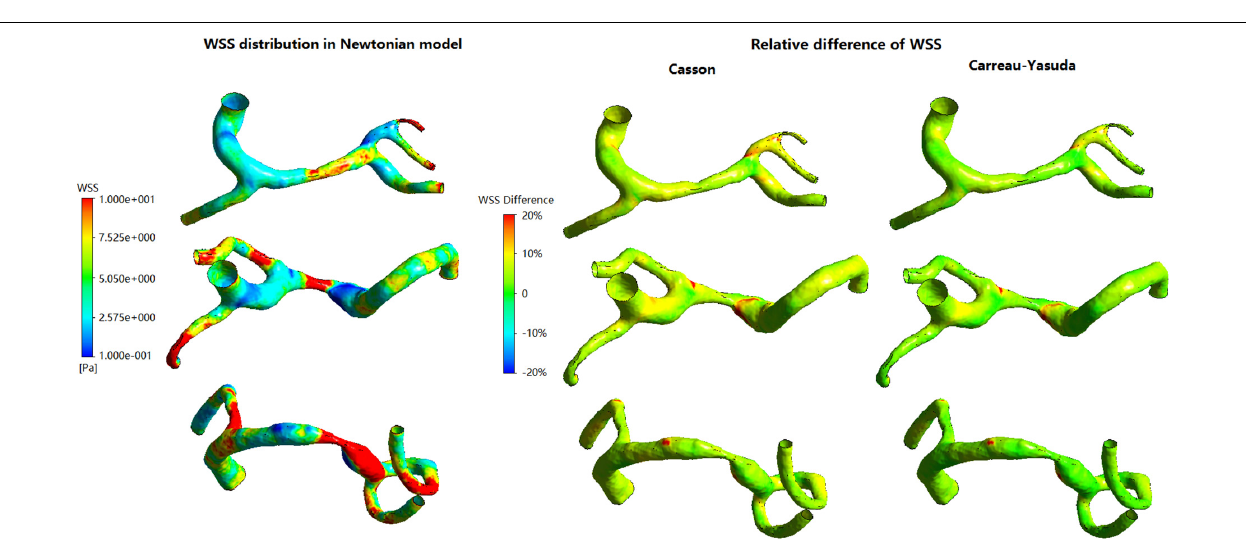
FIGURE 3 | The distribution of WSS in Newtonian model, and corresponding relative difference distributions in non-Newtonian